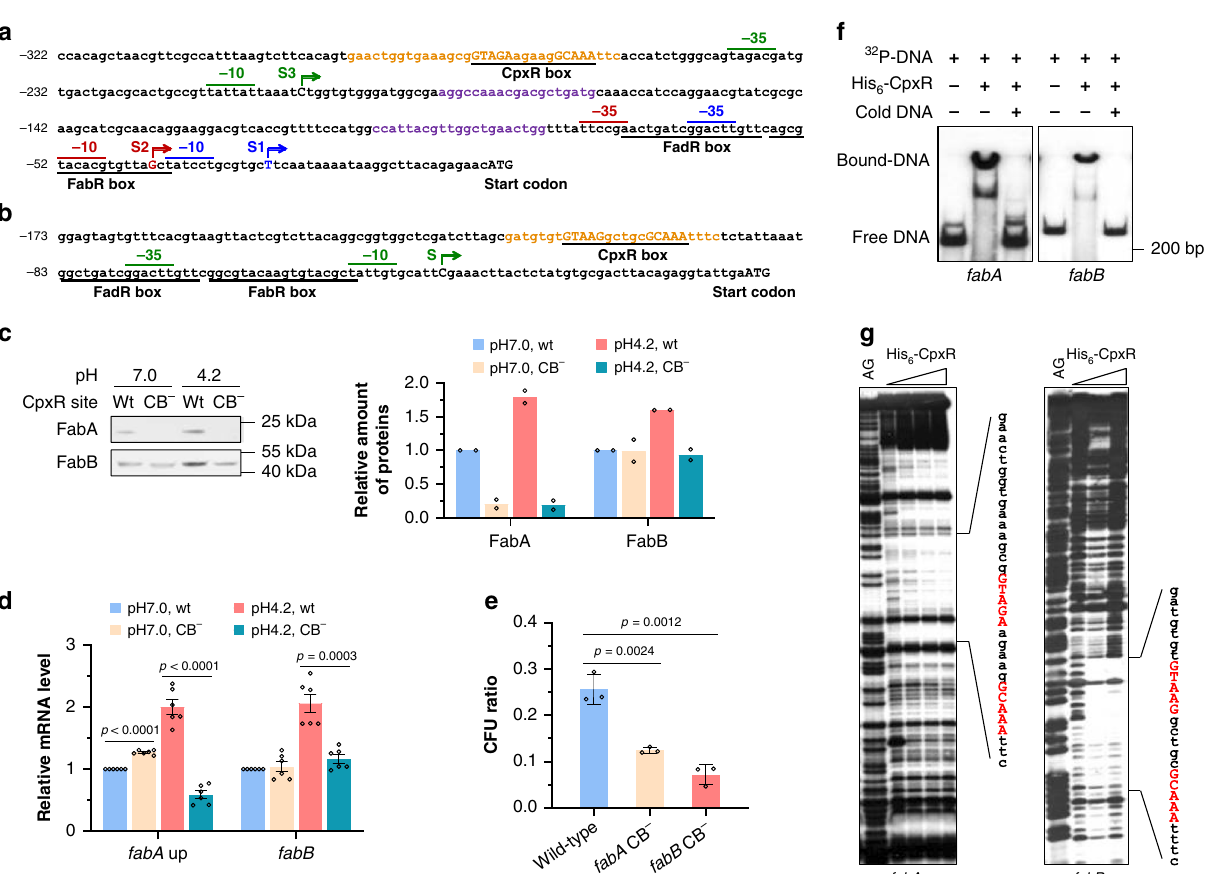
Fig. 3 Identi fi cation of CpxR binding sites in the fabA and fabB promoters. a , b DNA sequences of fabA and fabB promoter regions. The FabR box, FadR box and CpxR box sequences were underlined. Two previously reported transcription start sites of fabA , S1 and S2, and corresponding − 35 and − 10 regions were shown in blue and red, respectively. The transcription start site identi fi ed in this study and its − 35 and − 10 regions were shown in green. Numbering is from the start codon of each gene. c Western blot analysis of FabA-His 6 and FabB-His 6 in BW25113 wild-type strain at pH 7.0 and 4.2, and strain with CpxR site substitution at pH 7.0 and 4.2. n = 2 biologically independent samples. CB − substituted CpxR box. d Relative mRNA level of fabA and fabB determined by qRT- PCR in BW25113 wild-type strain at pH 7.0 and 4.2, and strain with CpxR site substitution at pH 7.0 and 4.2 ( n = 2 biologically independent samples with three technical repeats). The fabA up primer sequences were shown in purple in ( a ). e Acid tolerance of BW25113 wild-type strain and mutants with substitution in fabA or fabB CpxR box after acidic challenge at pH 4.2 for 1h ( n = 3 biologically independent samples). f Gel-shift assay. 32 P-labeled DNA fragments containing fabA and fabB promoter regions were incubated without and with His 6 -CpxR protein, shown in lanes 1 – 2. Lane 3 is the same as lane 2 but supplemented with “ cold ” DNA fragments. g DNase I footprinting analysis of fabA and fabB promoters with probes for the noncoding strand and increasing amount of His6-CpxR protein. His 6 -CpxR-DNA mixture were subjected to 5% polyacrylamide electrophoresis, and visualized by autoradiography. The regions protected by CpxR protein were shown in orange in ( a , b ). AG, DNA sequence ladder generated with the same primers using a Maxam and Gilbert A + G reaction. f and g are representative results from two independent experiments. Error bars, mean±SEM. Two-tailed Student ’ s t tests were performed to determine the statistical signi fi cance for two group comparisons. The source data are provided as a Source Data fi